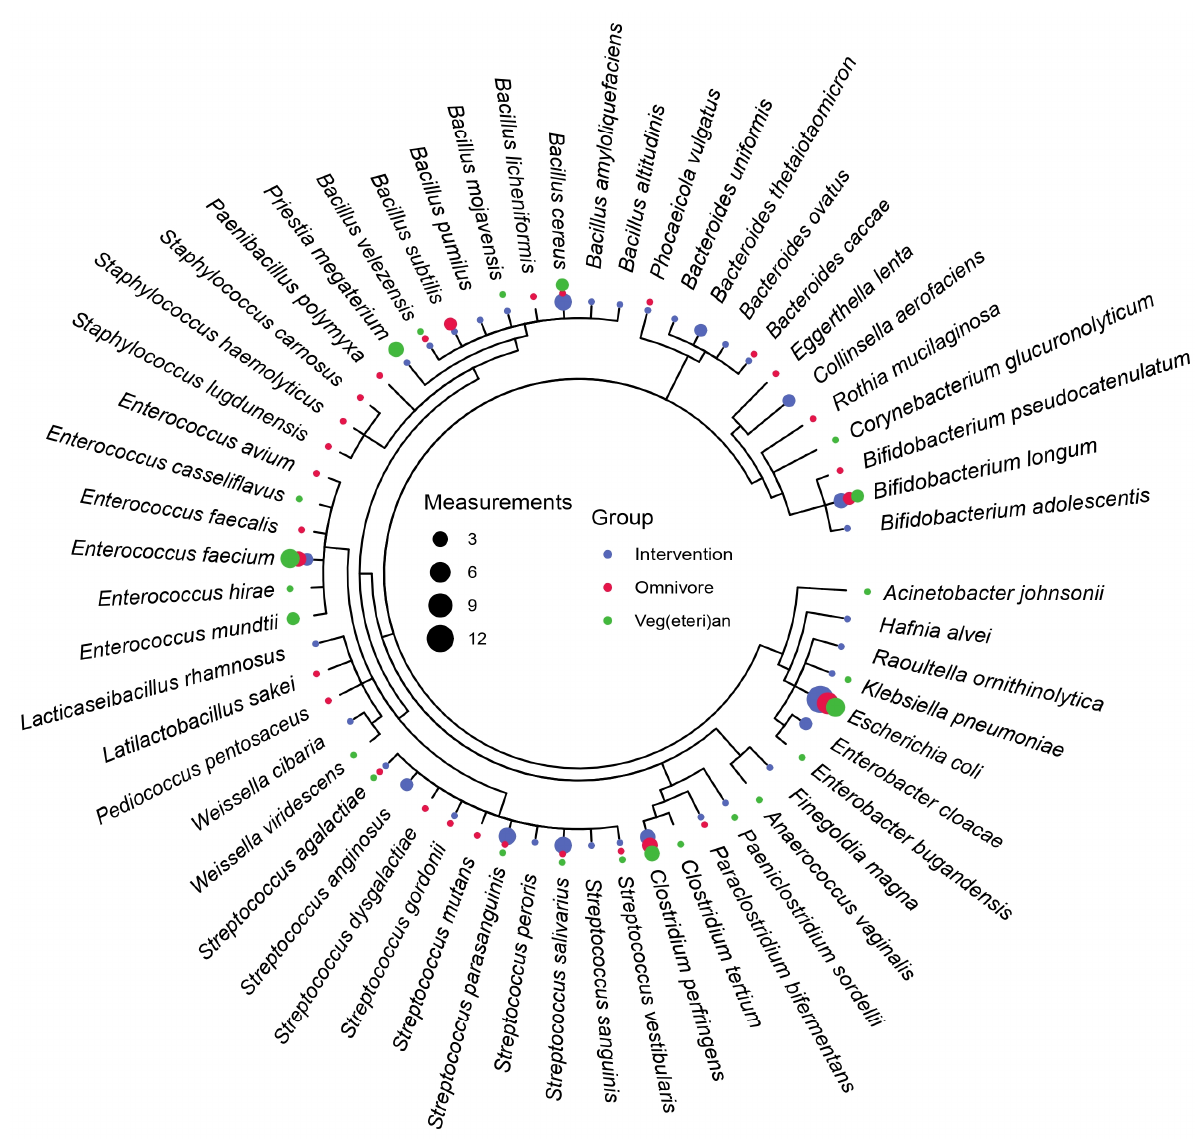
Figure 4. NCBI taxonomic classification of the species identified by mass spectrometry. The indicated number of measurements for the different diets represents the number of times the species has been identified in different samples at any time